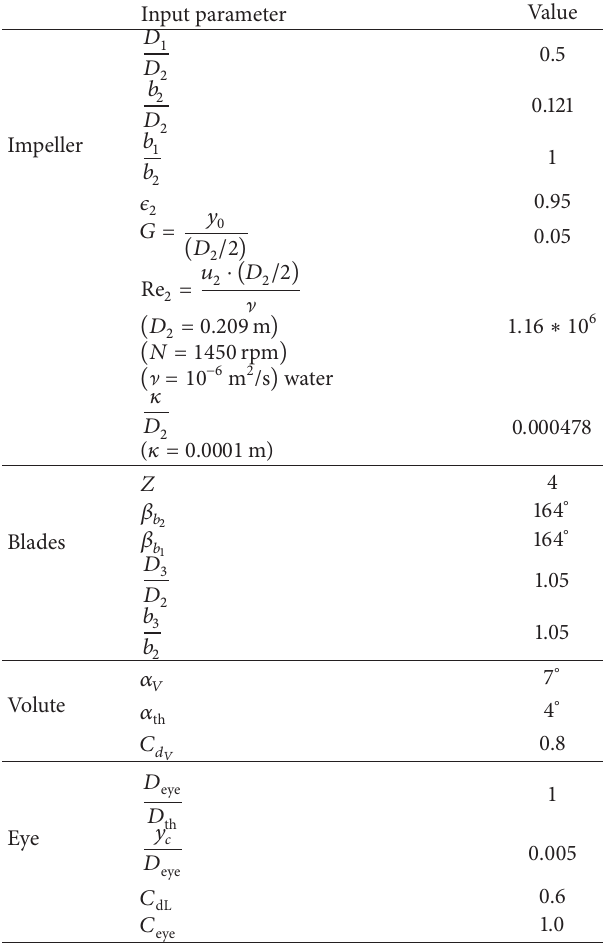
Table 1: Pump input-parameters.